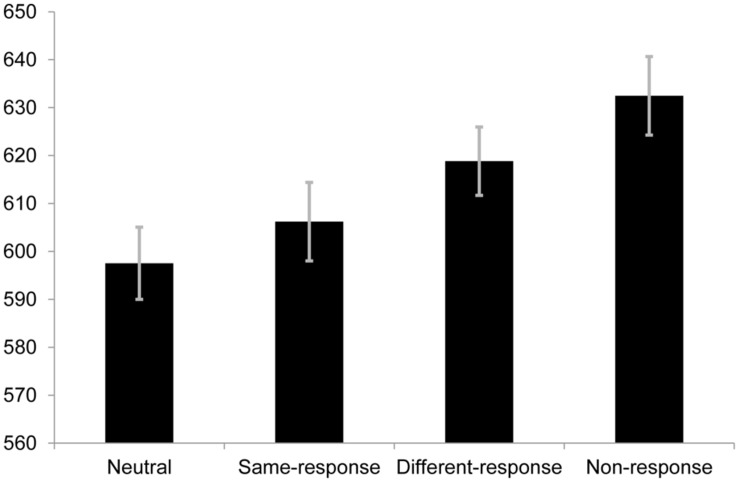
Mean RTs (in ms) for each condition in Experiment 2B. Error bars represent SE.